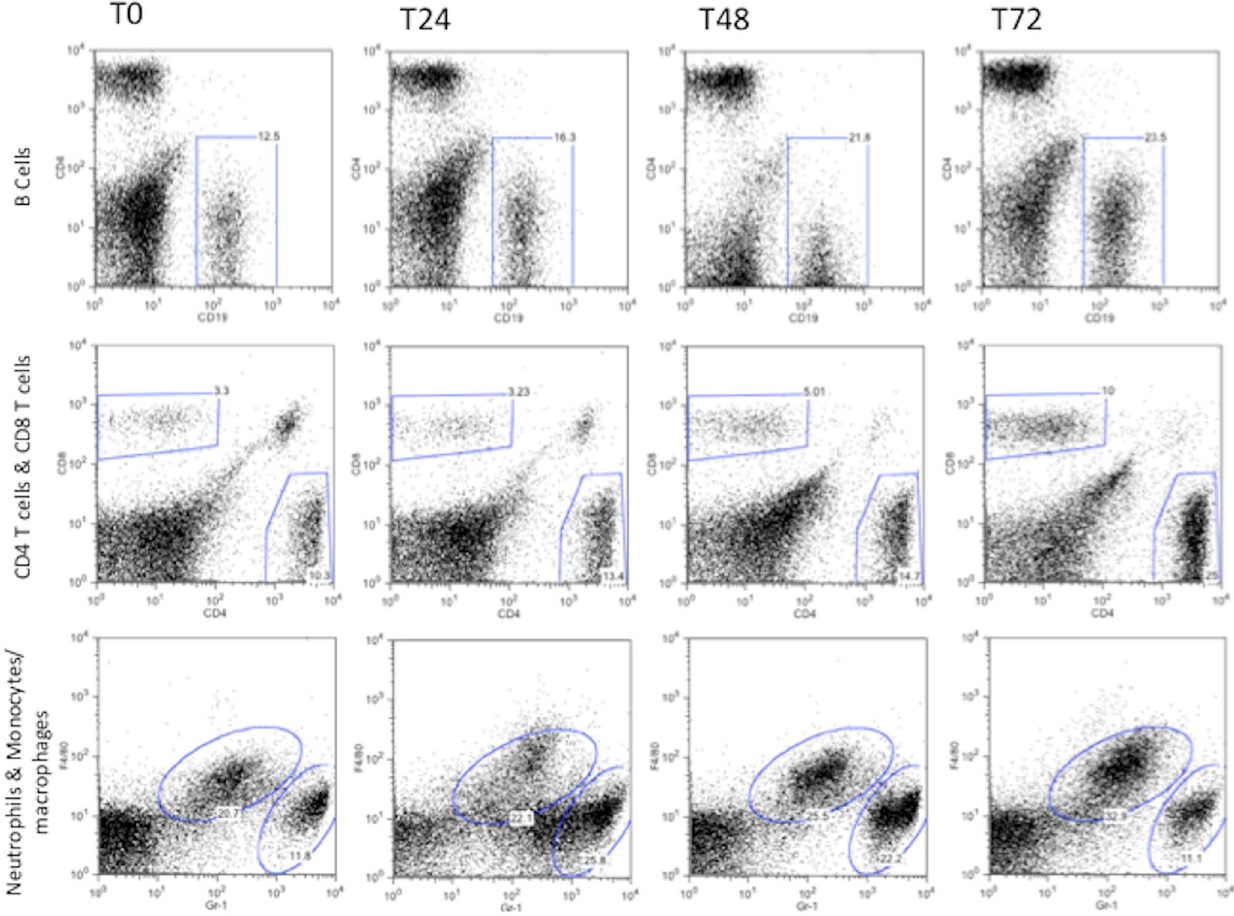
Figure 3. FACS analysis of lung inflammatory cells following P.aeruginosa LESB65 infection of mice. Representative FACS plots showing immune cell staining of airway cells. Each column shows plots from an individual mouse at each time point. All plots are lung CD45 + cells and gates were drawn relative to isotype control antibody staining for each marker. Top row shows B cells [CD45 + , CD19 + ], middle row shows CD4 T cells [CD45 + , CD3 + , CD4 + ] and CD8 T cells [CD45 + , CD3 + , CD8 + ], bottom row shows neutrophils [CD4 + , Gr-1hi, F4/80-] and monocytes/macrophages [CD45 + , F4/80 + , Gr-1int/low]. Numbers on gates are percentages of total CD45 + cells.